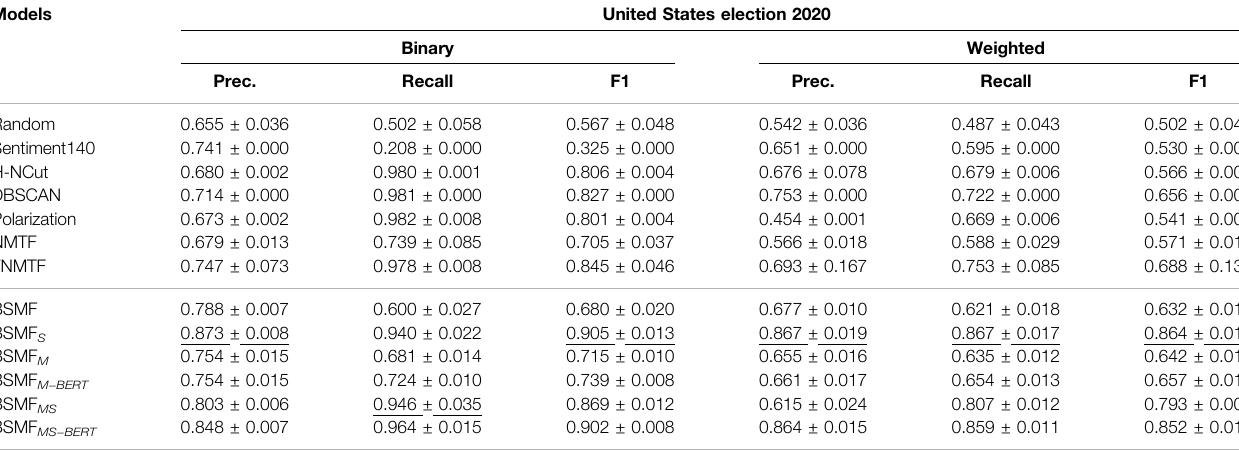
TABLE 2 | Binary- and weighted- metrics comparison (United States election 2020).